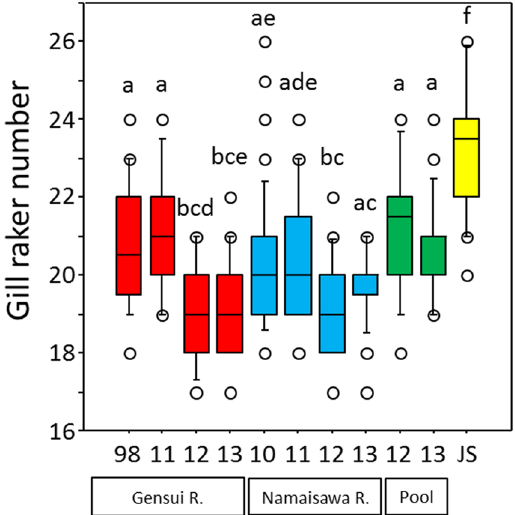
Figure 4. Box plots of the gill raker number. Letters above the boxes indicate the results of the pairwise post- hoc Mann-Whitney U -tests with Bonferroni corrections ( P < 0.0009): the same letters indicate the absence of significance in the pairwise comparison, whereas different letters indicate significant differences between groups with different letters. Specimens in 1998 and 2010 were collected before the tsunami, whereas those in 2011– 2013 were collected after the tsunami. JS denotes anadromous populations of G . nipponicus caught in 2003.